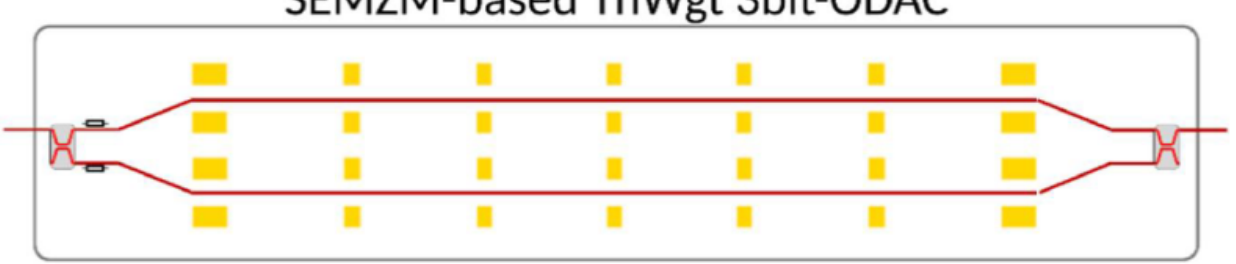
Figure 19. Segmented MZM (SEMZM) seven segments of the oDAC architecture-optimized ther- mometer weighted DAC structure for generation of pulse amplitude modulation (PAM)8 [57].